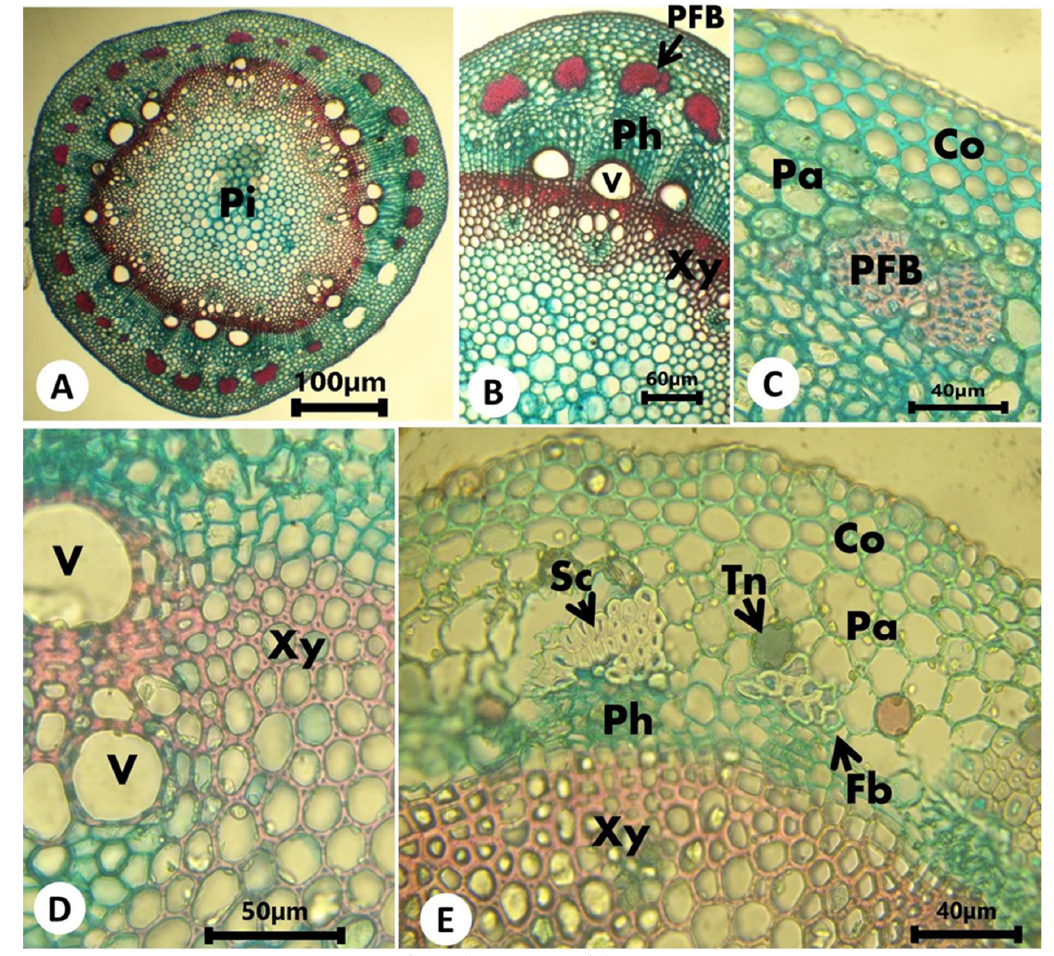
Figure 7. Transverse sections of Stem (A – D) and tendril (E) of A. lobata Pi = pith, Xy = xylem, Ph = phloem, Fb = fibre, G = secretory gland, Pa = cortex parenchyma, Co = collenchyma, V = vessel, sd =